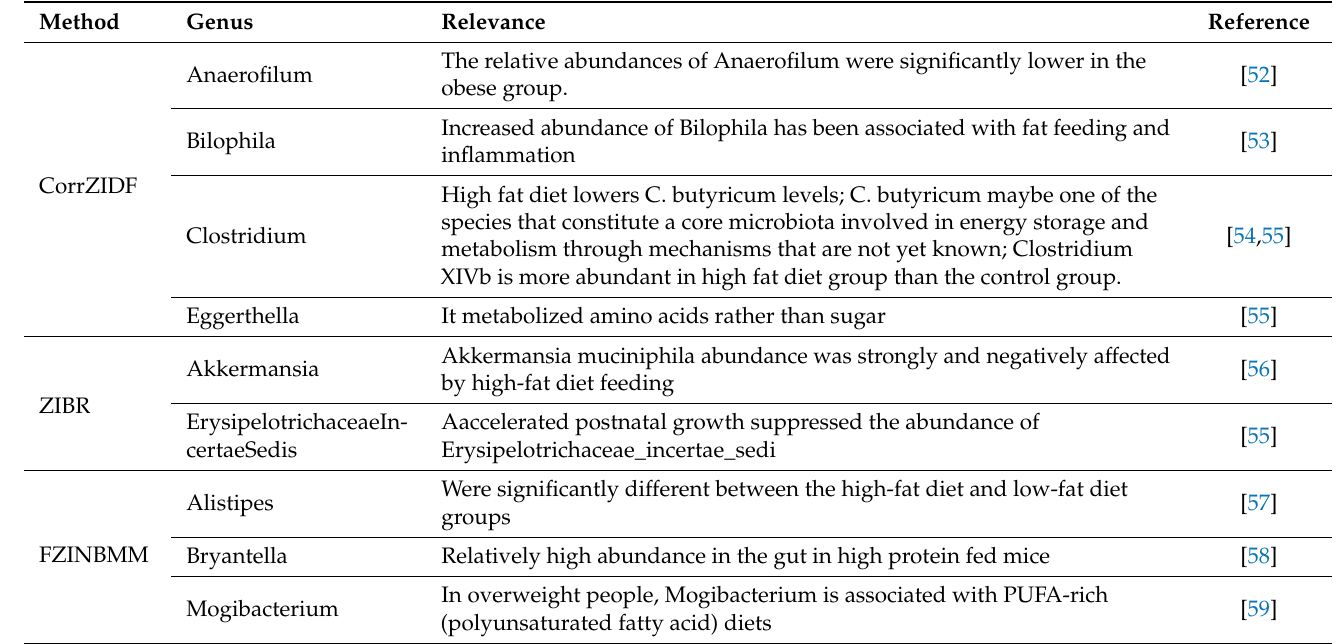
Table 3. List of unique genera by each method for the mouse diet